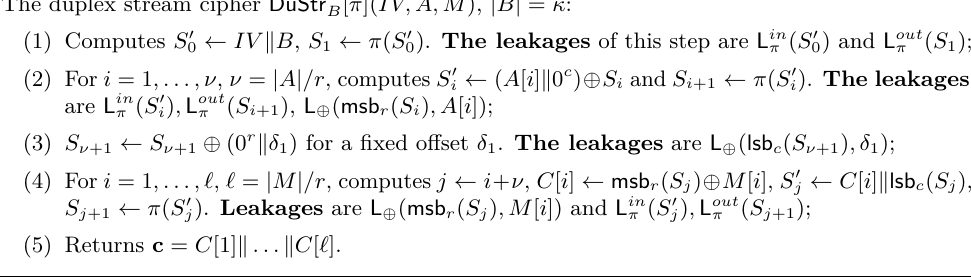
Figure 2: The duplex-based stream cipher DuStr and the involved